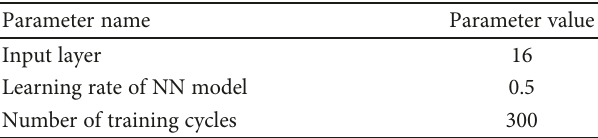
Table 4: Parameters of the SAE obtained using the grid search method.